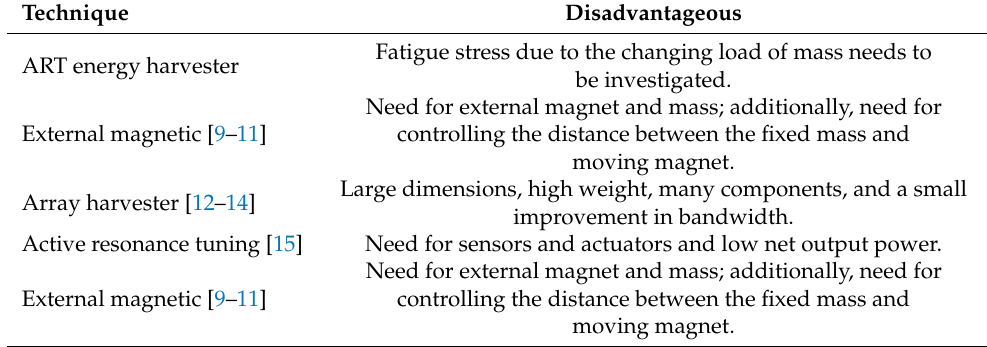
Table 8. Comparison of the ART broadband technique with other techniques.